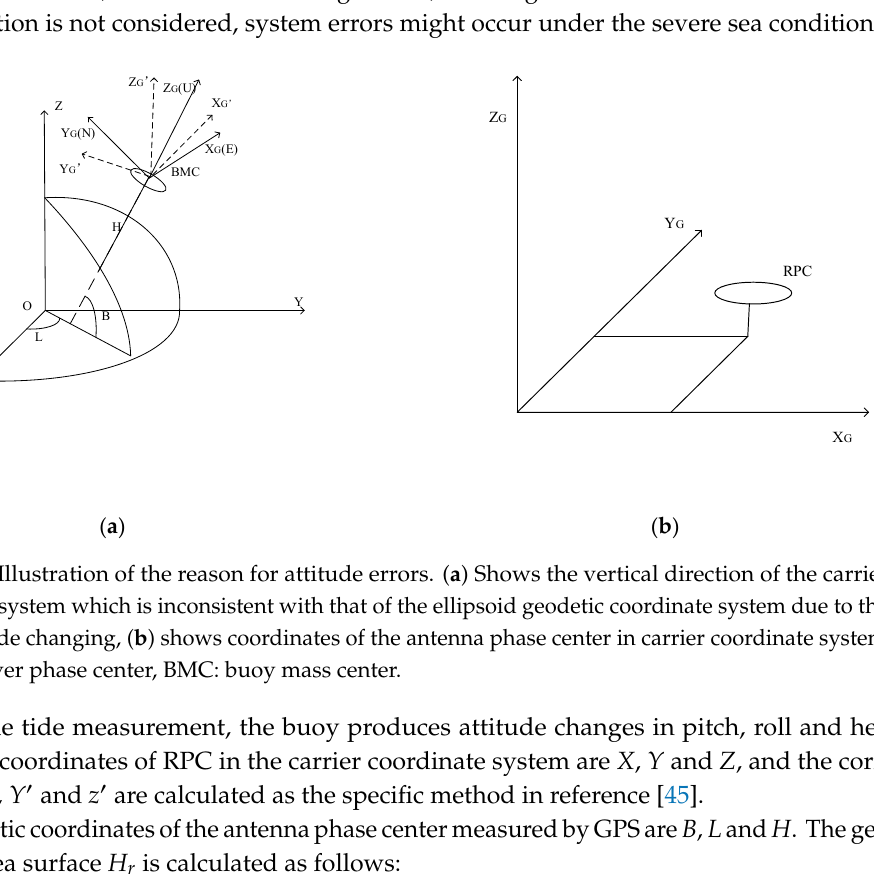
Table 7. Comparison of the RT-PPP tide measurement results with the tide gauge data. Compared